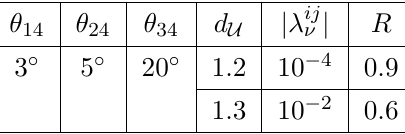
Table 1 . The ratio of muon yields at IceCube for UHE neutrinos from a GRB with and without unparticle decay in a four neutrino framework. See text for details.